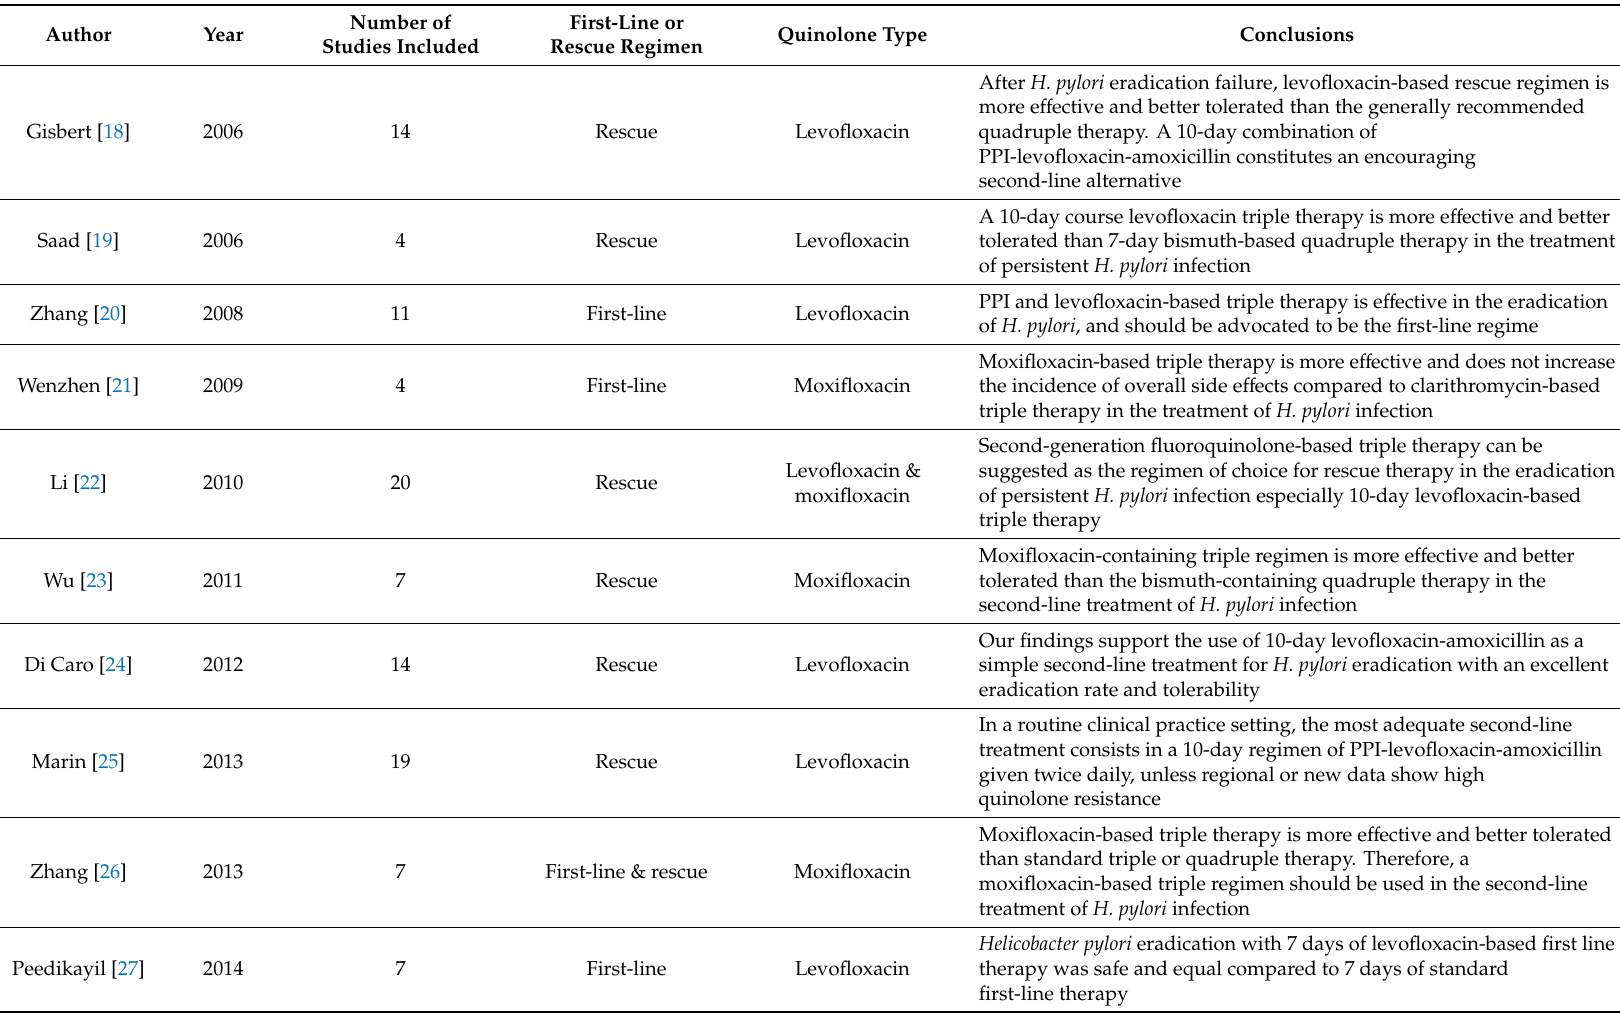
Table 1. Meta-analyses evaluating the e ffi cacy of H. pylori quinolone-based